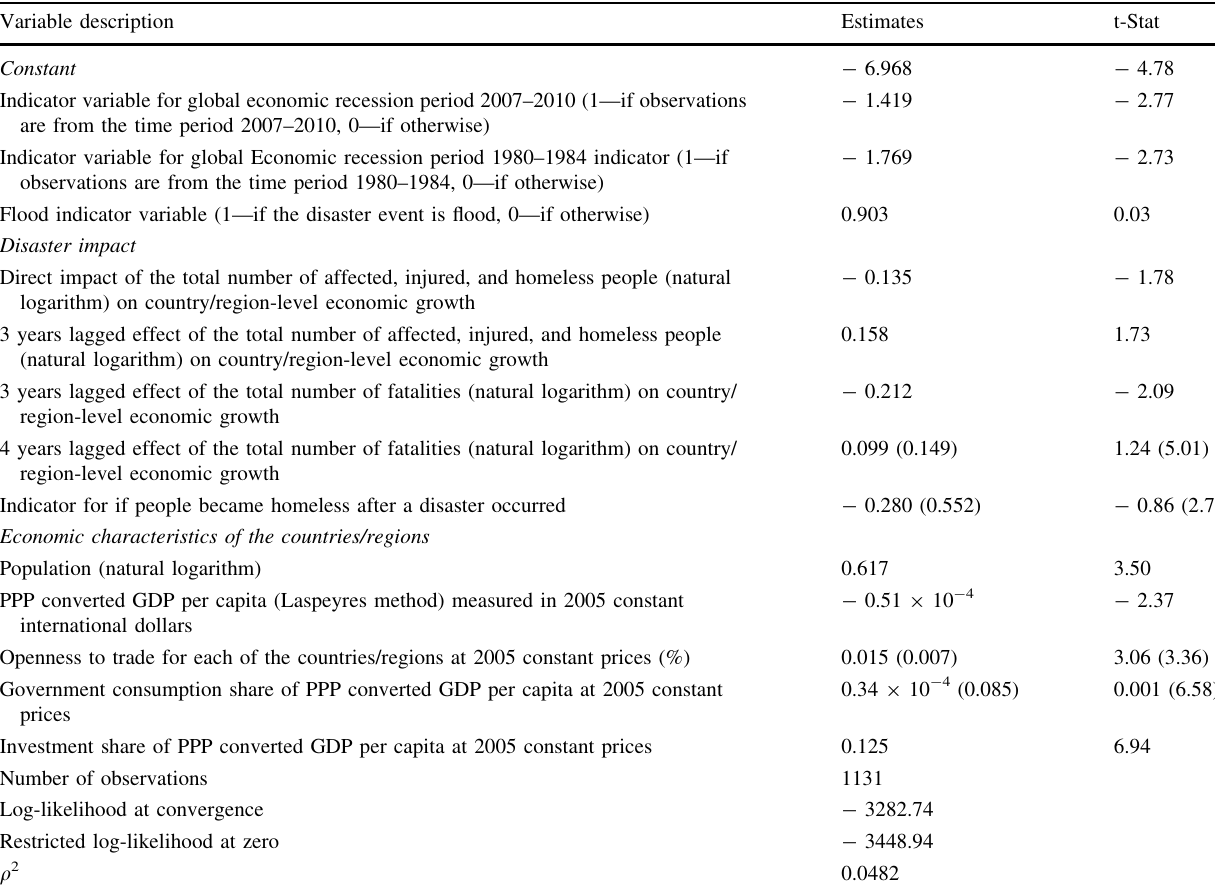
Table 2 Random parameter panel data model to estimate the impact of natural hazard-induced disasters on country/region-level economic growth (SD of the significant random parameters are given in parentheses) Variable